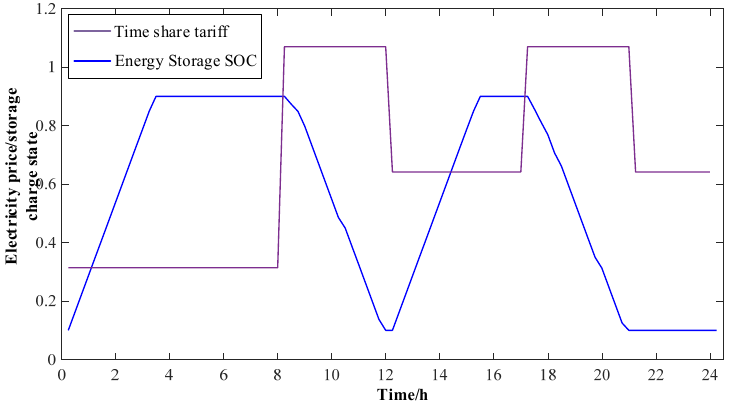
Figure 8. Time-share tariff and SOC change curve of energy storage system in Scenario I.